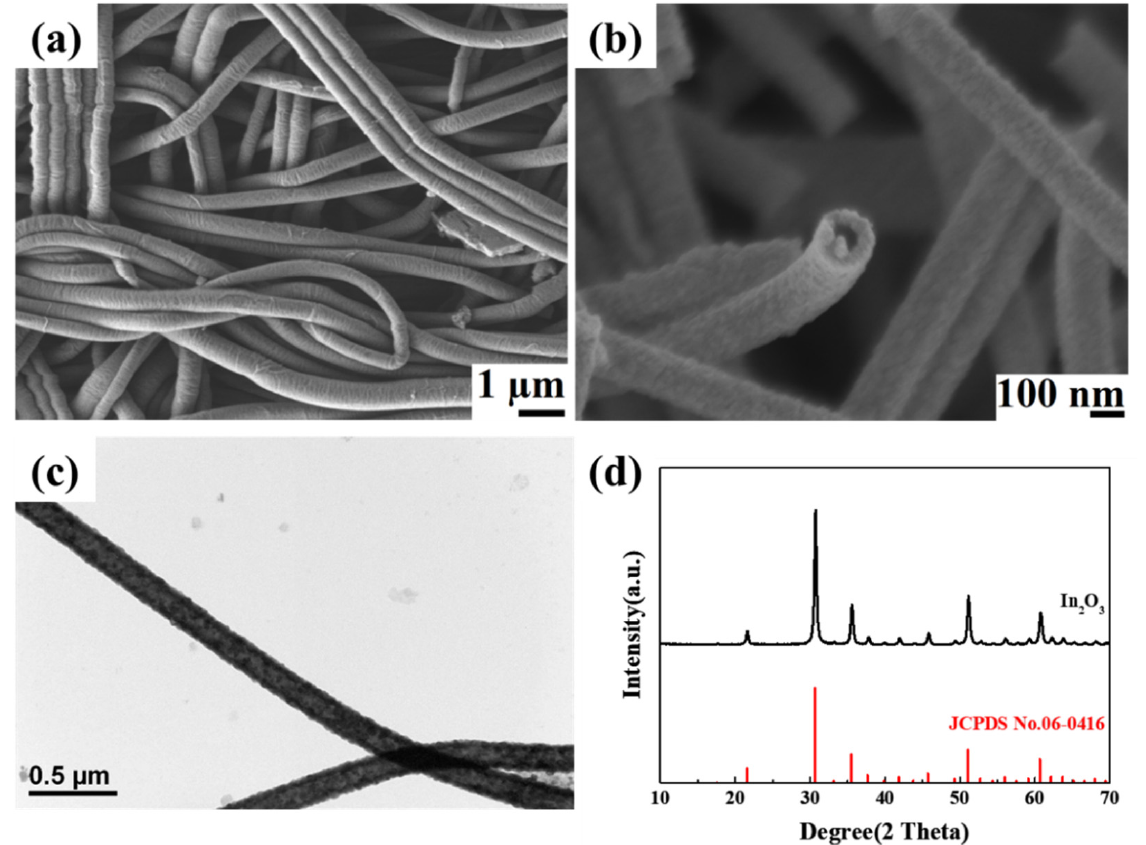
Figure 2. ( a ) SEM images of In 2 O 3 /PVP electrospun fibers; ( b ) SEM images of hollow In 2 O 3 nanofibers after 800 °C calcination; ( c ) TEM images of hollow In 2 O 3 nanofibers; and ( d ) WAXD pattern of hollow In 2 O 3 nanofibers.